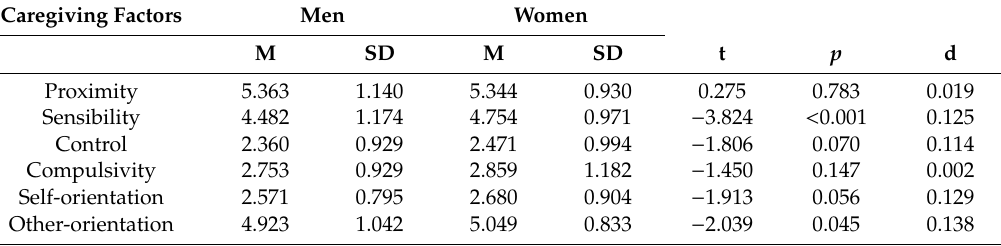
Table A1. Comparison in CQ dimensions according to sex.